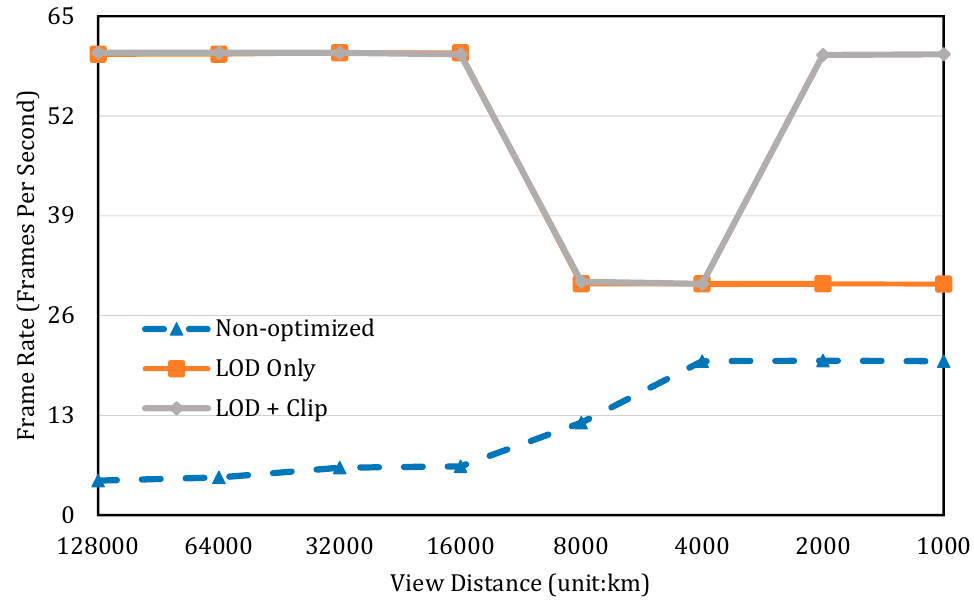
Figure 7. Comparison of data rendering performance, before and after applying optimization strategies.